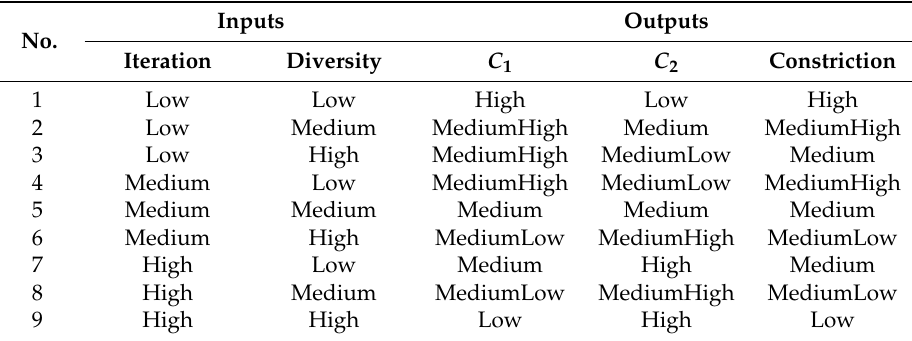
Figure 4. Interval type-2 fuzzy system for dynamic parameter adaptation in PSO. Table 2. Fuzzy rules for dynamic parameter adaptation in PSO.